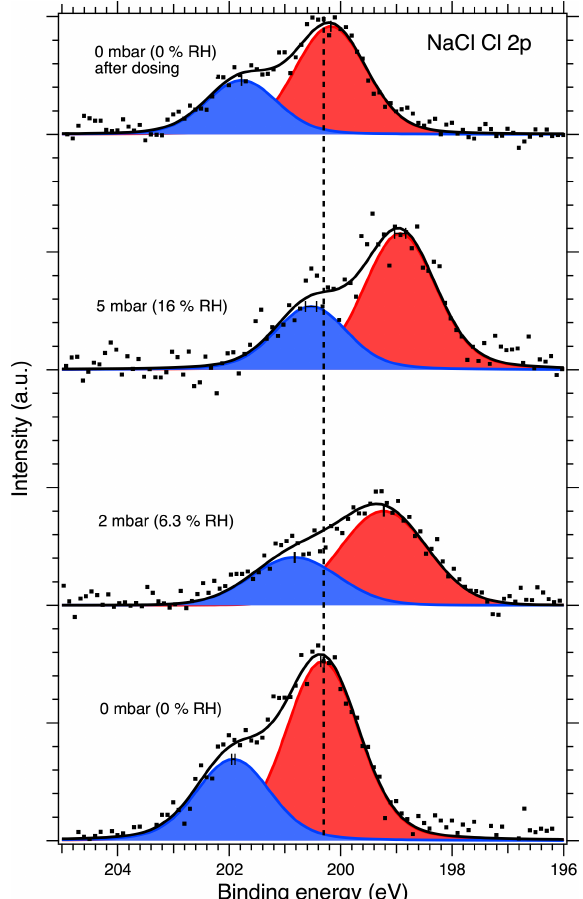
Figure 2. Cl 2p XPS spectra of NaCl aerosol particles recorded at different water vapor pressures (relative humidities, RH). The dots show the recorded data, the solid lines the fit envelope curve, and the red and blue peaks the fitted 3 / 2 and 1 / 2 spin-orbit components, respectively. The dashed vertical line shows the binding energy of the Cl 2p 3 / 2 component at 0mbar pressure (0% RH) at the begin- ning of the experiments. Error bars show the estimated uncertainty in the peak position from Monte Carlo analysis. Photon energy was 1486.6eV from the Al